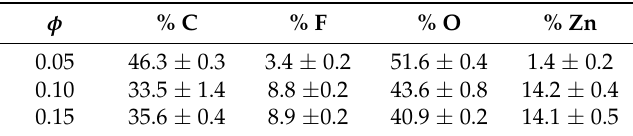
Table 2. ZnO-CF x surface elemental composition as a function of the metal oxide volume fraction φ . Errors are calculated as standard deviation on three